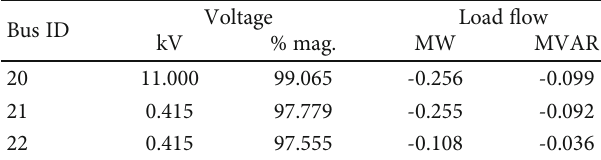
Table 5: Load fl ow of N-M network for Case 1.